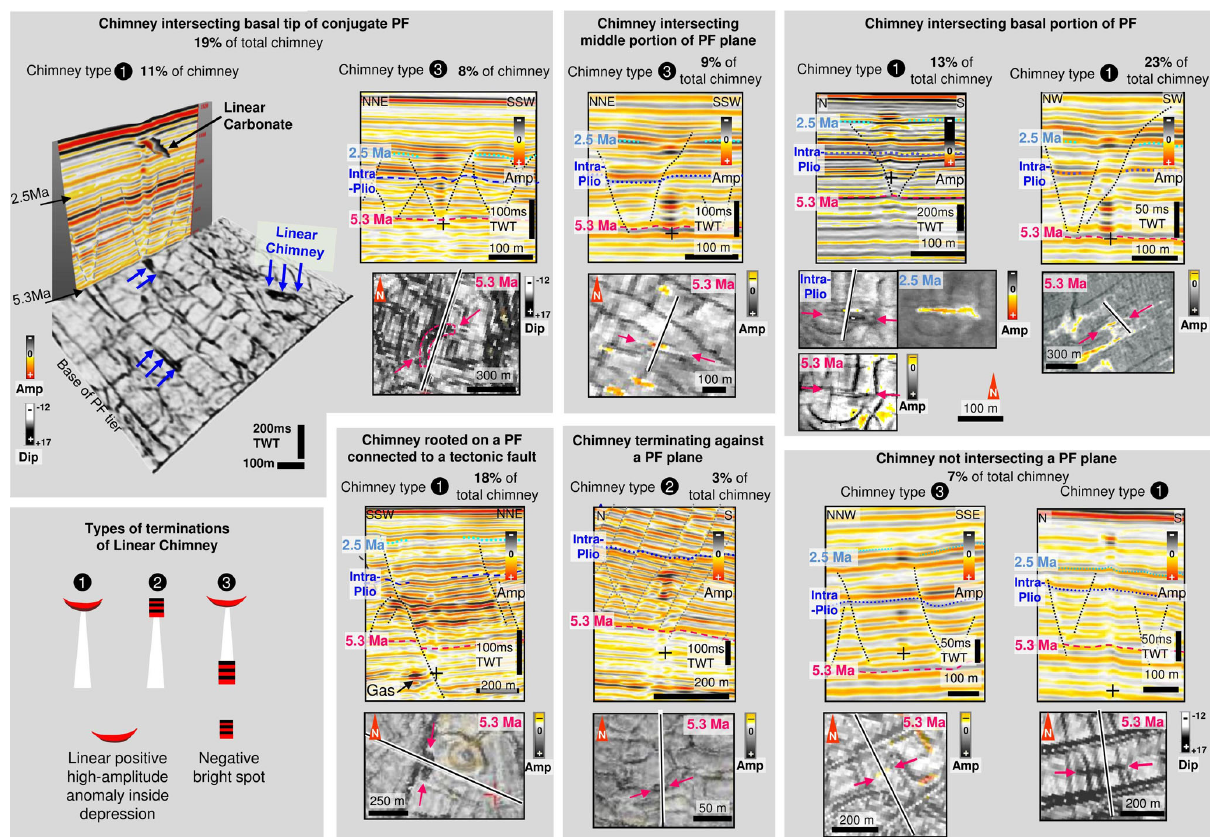
Figure A3. Examples of different groups of chimneys intersecting and emanating from different parts of polygonal faults (PFs). The linear vents of Type-1, 2, and 3 are labelled with black circles. The percentages correspond to the numbers of chimneys intersecting fault planes at specific positions (see pie chart in Fig. 12). The planform dimensions of the chimneys are shown on maps below each section. The apparent bases of chimneys are marked with crosses. See description in Sect.